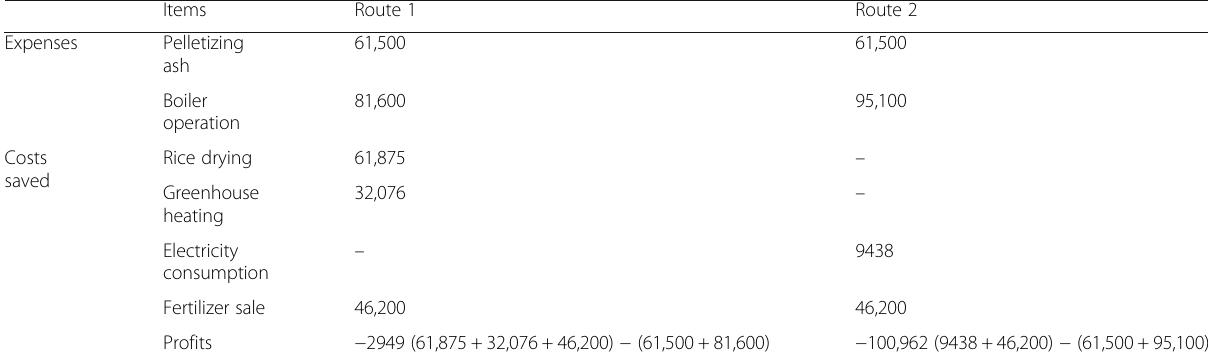
Table 7 Expenses and costs saved in Routes 1 and 2 (USD)